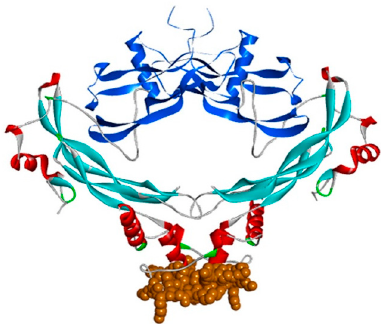
Figure 4. The heparin binding site of noggin in the noggin-BMP-7 complex (co-ordinates from 1M4U.pdb). Noggin is shown as described in Figure 1, with amino acids 133–144, encompassing a cluster of eight basic arginine and lysine residues, shown in brown CPK format; BMP-7 is shown in blue ribbon format.